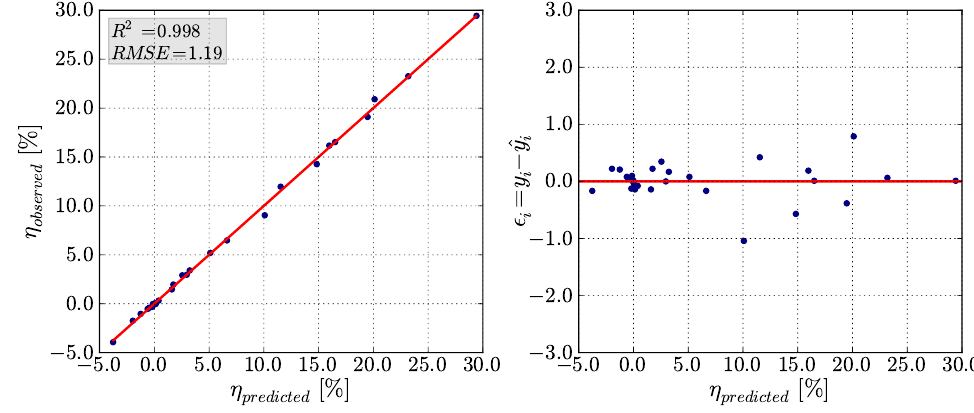
Figure 4. Predictions of the surface response design. R 2 =